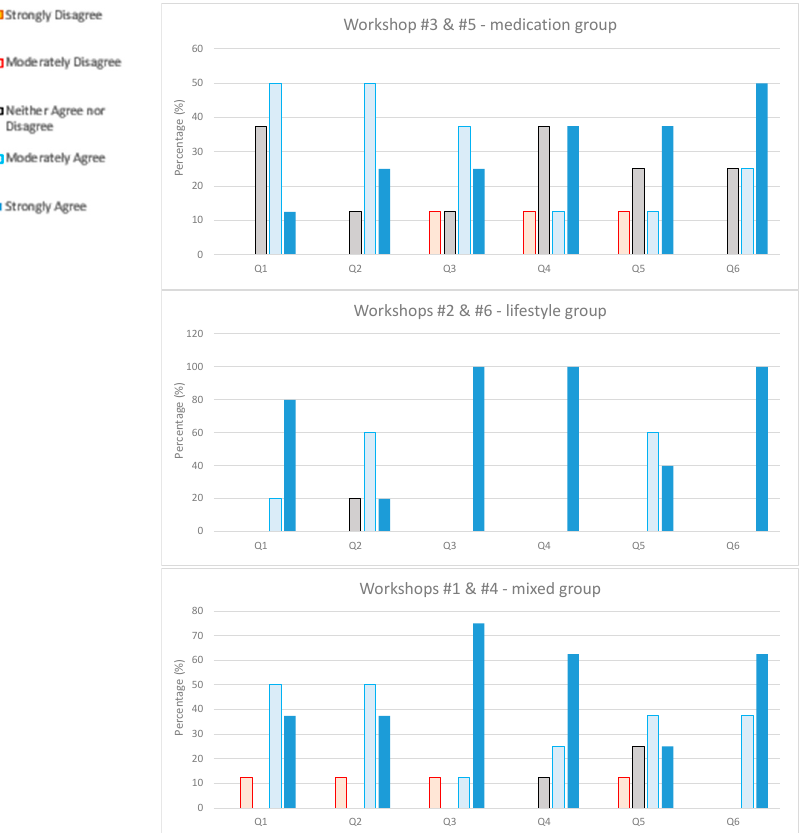
Figure 1. Distribution of responses collected from the post-workshop survey from patients in the medication ( top panel ), lifestyle ( center panel ), and mixed ( bottom panel ) groups. Questions: Q1: After this workshop I feel better about managing my condition; Q2: I learned new information during the workshop; Q3: The information and interactions during the workshop were useful to me; Q4: I plan to act on the information I obtained in the workshop; Q5: I believe I will achieve my goal within the next three months; Q6. I am motivated to set a goal for improving my